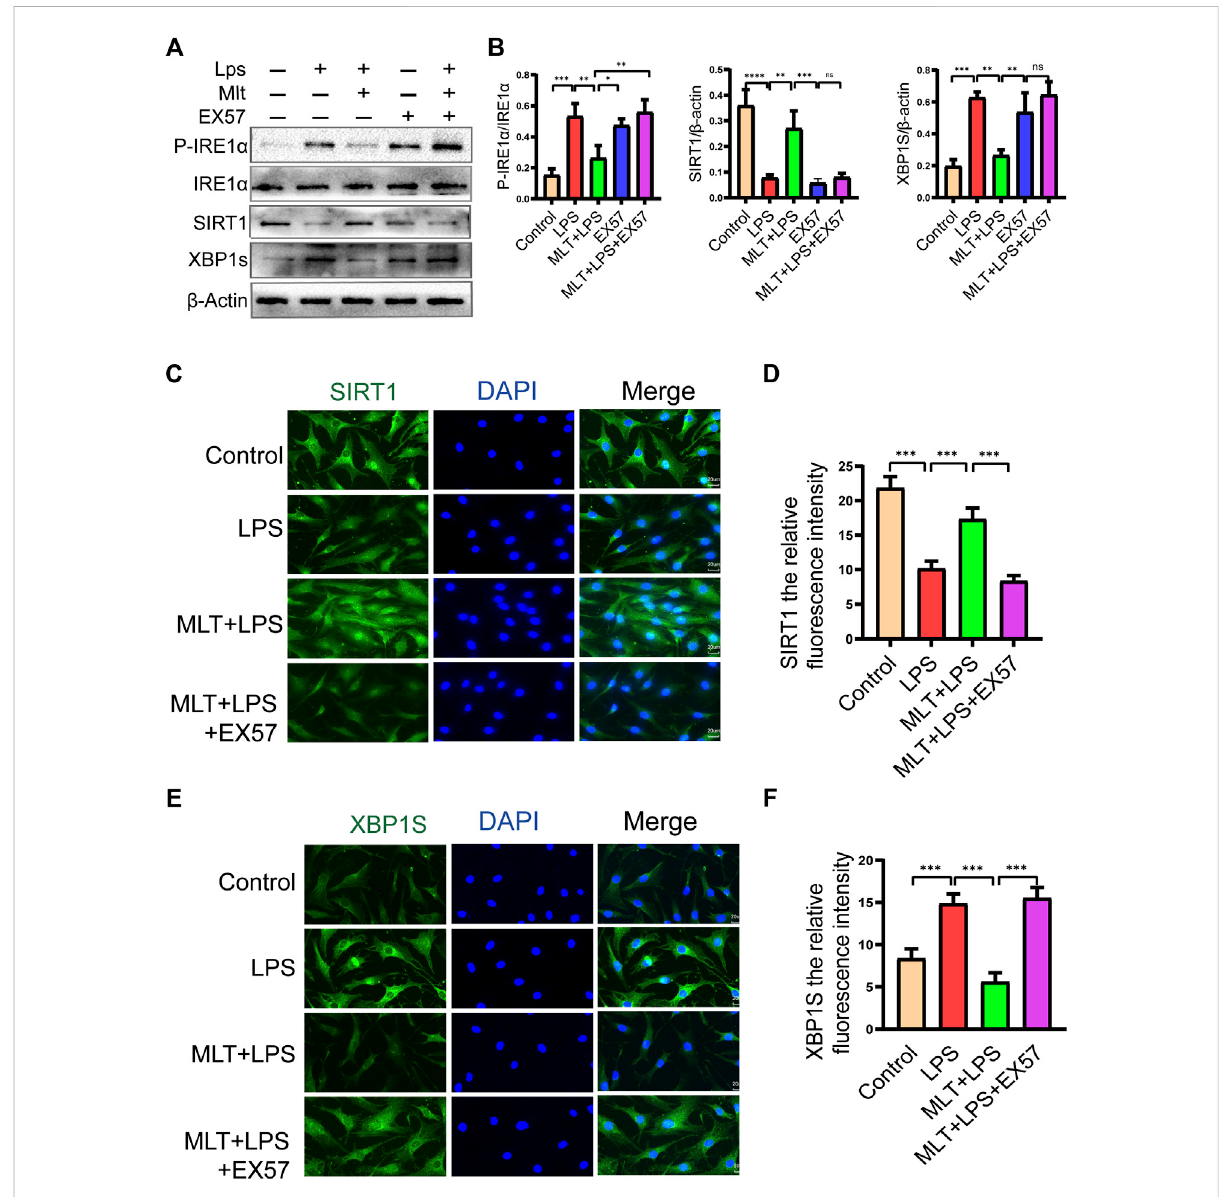
FIGURE 6 EX527 eliminated the protective effect of melatonin on human chondrocytes stimulated by lipopolysaccharide by inhibiting the inositol – requiring enzyme 1 α – X – box – binding protein 1s (IRE1 α – XBP1S) pathway. (A,B) Western blot analysis was performed to detect the protein expressionlevelofSIRT1and P -IRE1 α ,IRE1 α andXBP1SafterEX527treatment. (C – F) Immuno fl uorescencestainingofsirtuin1(SIRT1)andXBP1S(bar, 20 μ m). ImageJ wasused to detect the fl uorescence intensity of SIRT1 and XBP1S. The experimentwas repeated three times